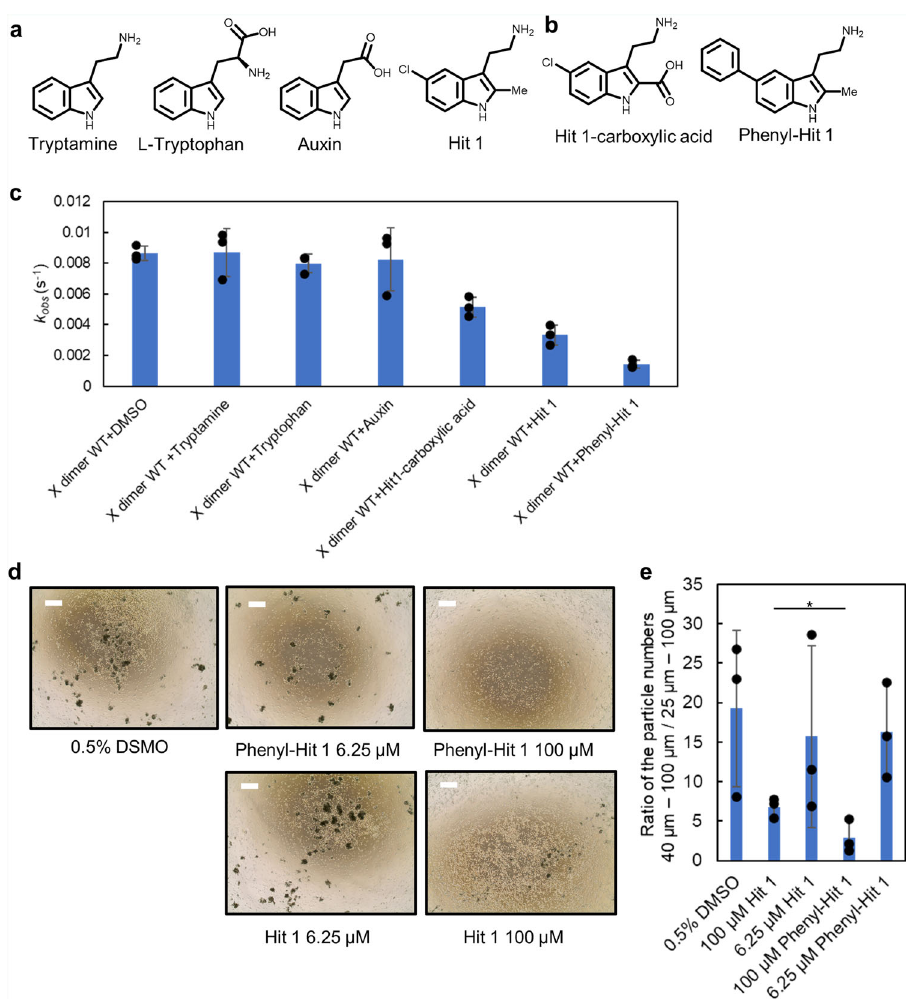
Fig. 5 Phenyl-Hit 1 more effectively inhibits aggregation than does Hit 1. a , b Chemical structures of the compounds investigated. c The k obs values for indicated compounds in the liposome aggregation assay. N = 3. Error bars show standard deviations. Individual data points are shown in black plots. d Representative images from cell-aggregation assay in the presence of a range of concentrations of phenyl-Hit 1. Scale bars indicate 500 µ m. N = 3. In order to compare the inhibitory activity of Hit 1 and phenyl-Hit 1, the same lot of cells was used for both compounds. e Quanti fi cation of cell-aggregation assay. N = 3. Error bars show standard deviations. *Signi fi cant difference ( P < 0.05 by one-sided Welch ’ s t test. P =